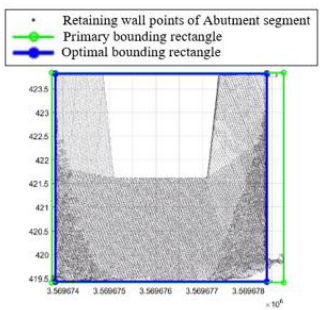
Figure 7. The optimal bounding rectangle fitted to the retaining wall points.